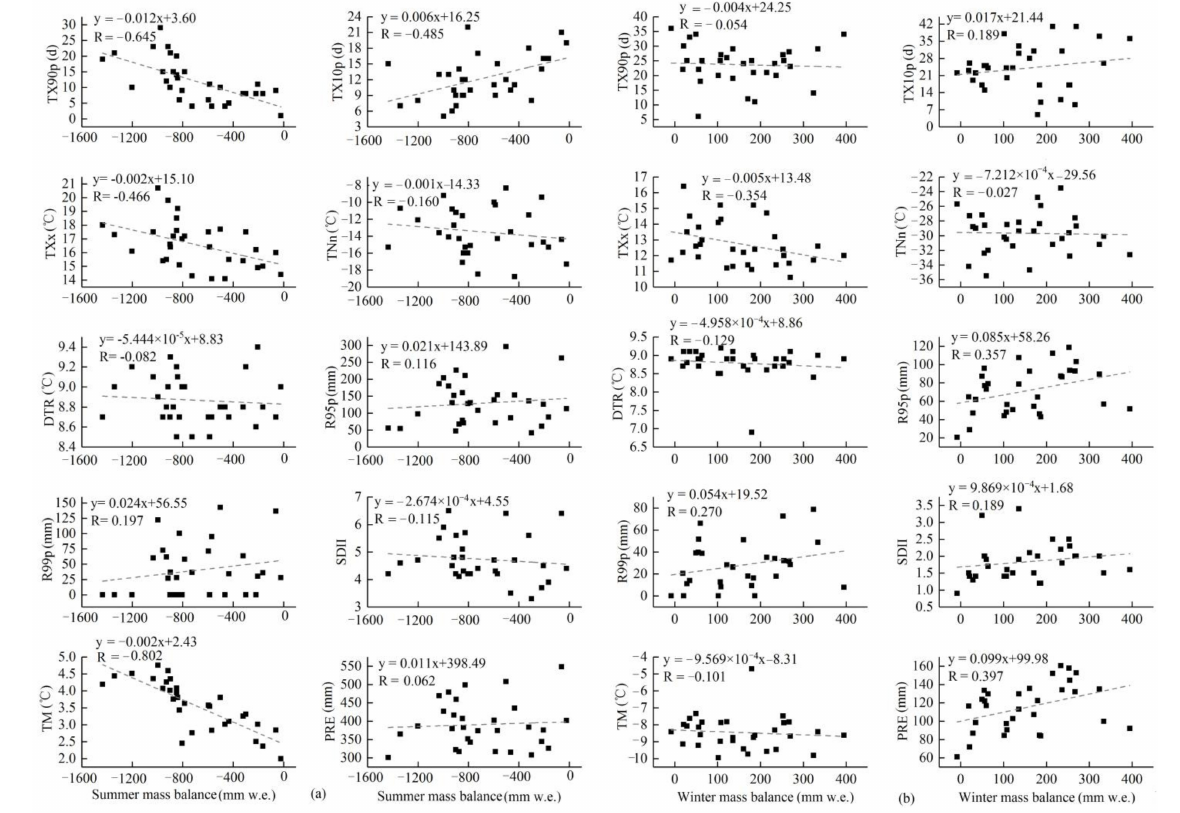
Figure 6. Correlation between mass balance of Urumqi Glacier No.1 in different seasons and extreme climate indices. The solid lines denote linear fit. ( a ) Summer mass balance. ( b ) Winter mass